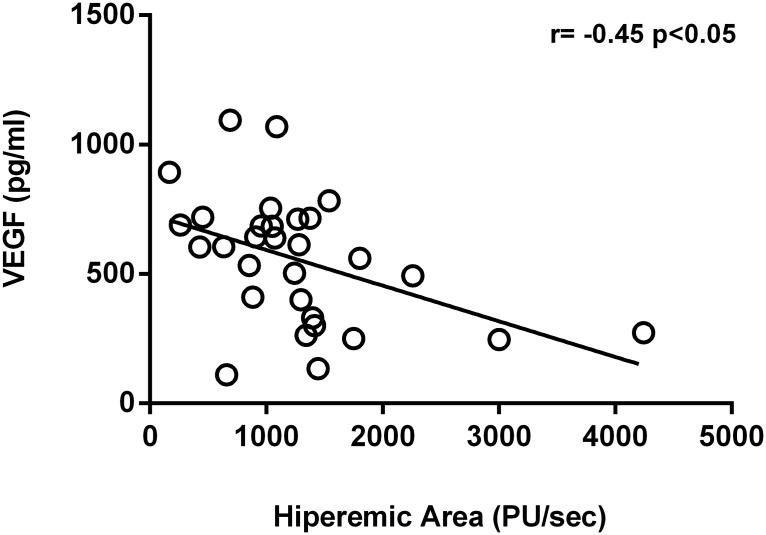
Relationship between flow mediated dilatation measured by Laser-Doppler flowmetry (hyperaemic area) and vascular endothelial growth factor (VEGF).